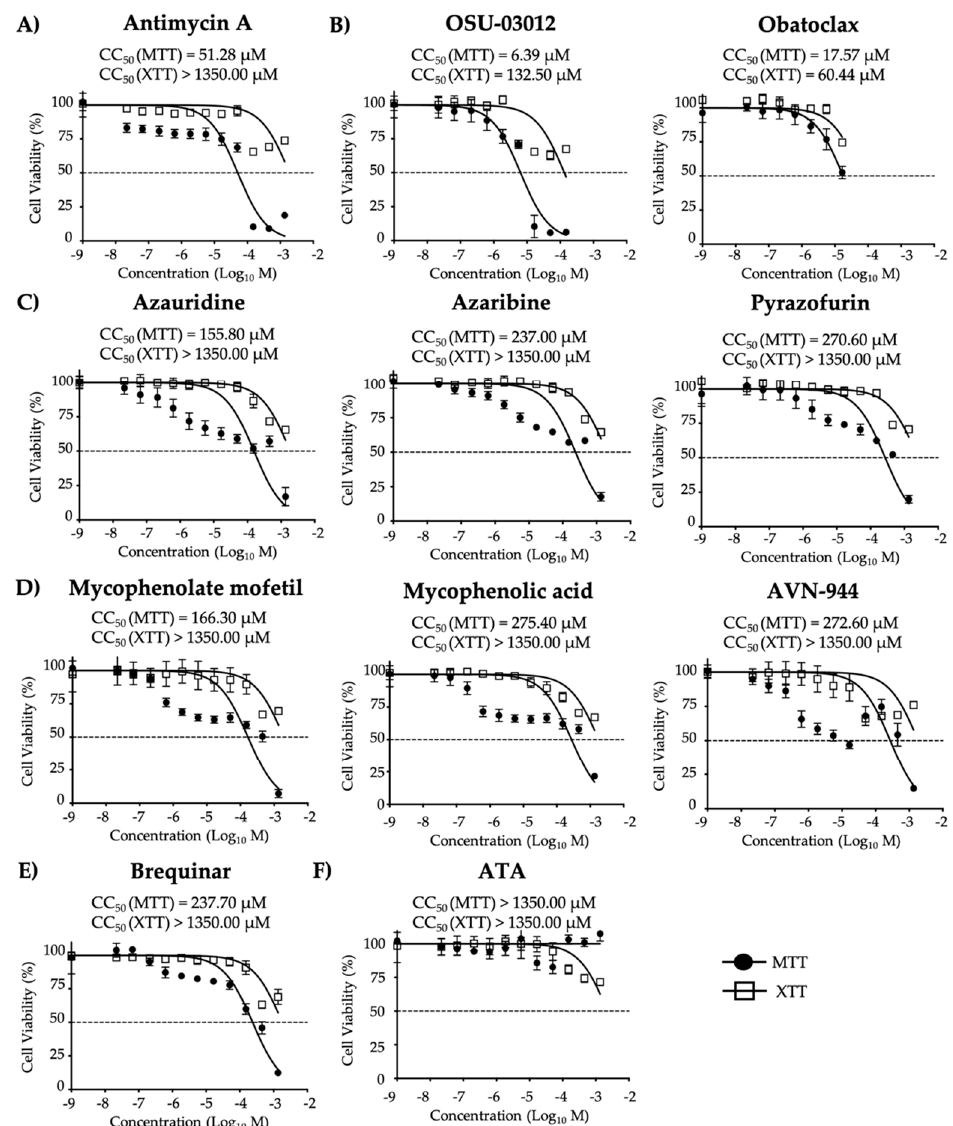
Figure 2. Cytotoxicity of the ten tested compounds: Vero cells (96-well plate format, 5 × 10 4 cells / well, quadruplicates) were incubated with DMEM 5% FBS containing the indicated doses of the inhibitors (3-fold serial dilutions, starting concentration of 1350 µ M) ( A ) Antimycin A, ( B ) OSU-03012 and Obatoclax, ( C ) Azaribine, Azauridine, and Pyrazofurin, ( D ) Mycophenolate mofetil, Mycophenolic acid, and AVN-944, ( E ) Brequinar, and ( F ) Aurintricarboxylic acid (ATA). Cell viability assays (MTT and XTT) were performed at 36 h post-treatment and the CC 50 for each compound was calculated. Dotted line indicates the 50% toxicity of each of the compounds. Data were expressed as mean and SD from three independent experiments conducted in